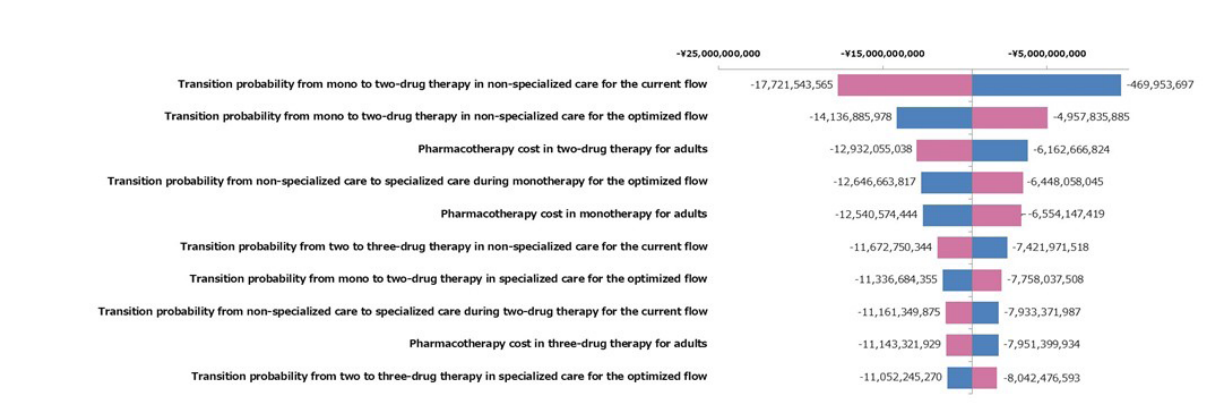
Figure 2: Tornado Diagram of One-way Sensitivity